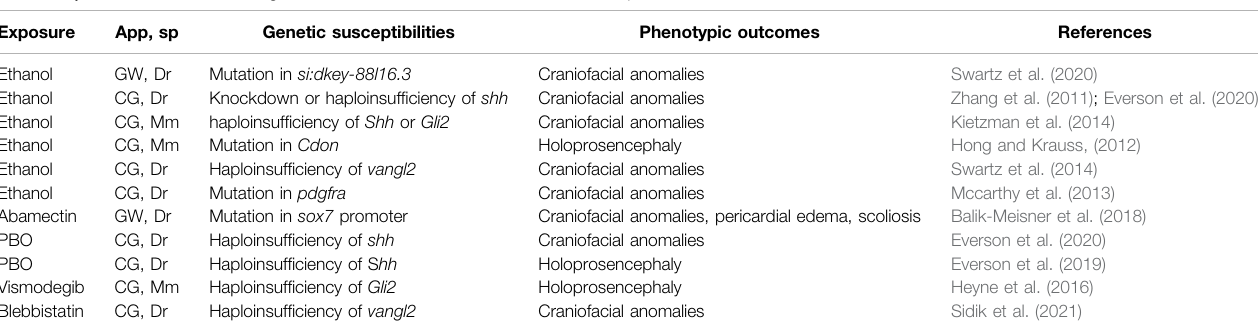
TABLE 1 | The reviewed studies of gene – environment interactions related to developmental disorders.